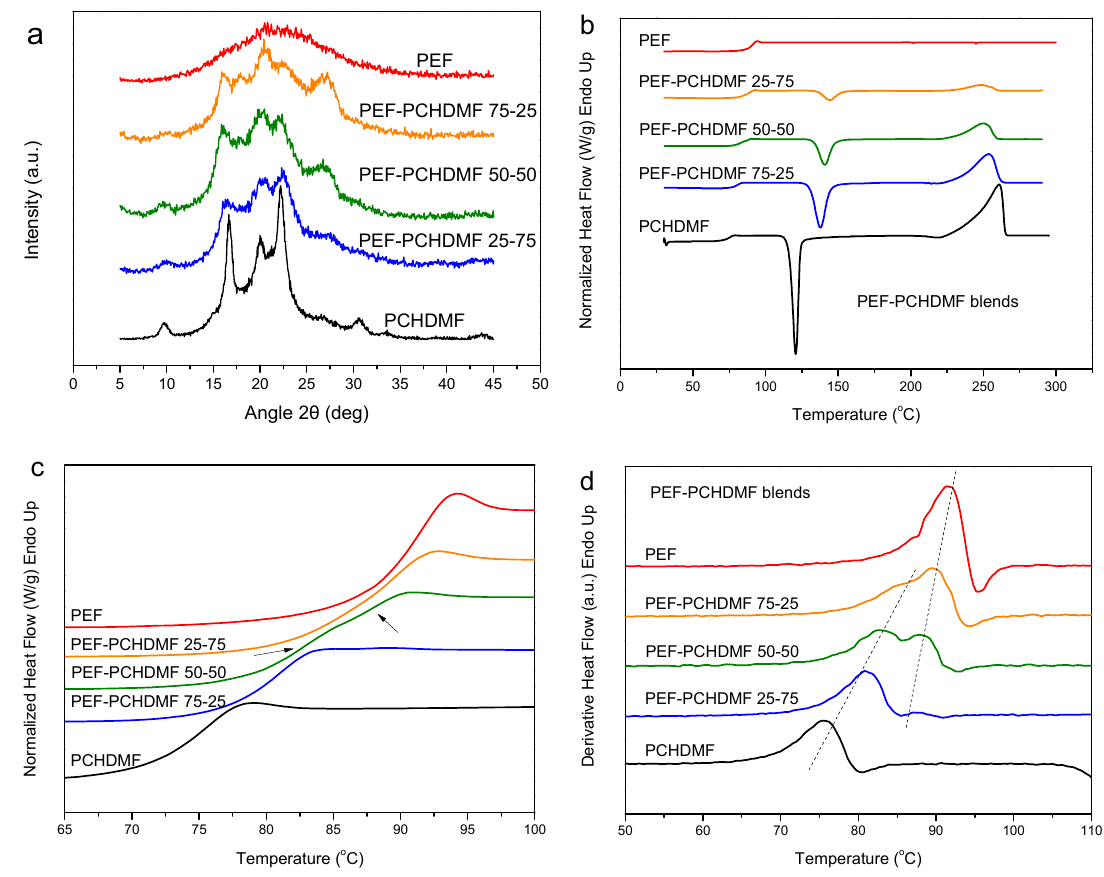
Figure 4. ( a ) WAXD patterns for as received PCHDMF–PEF blends, ( b ) DSC heating thermograms, ( c ) details of DSC thermograms in the T g region and ( d ) derivative heat flow for melt-quenched PCHDMF–PEF blend samples.